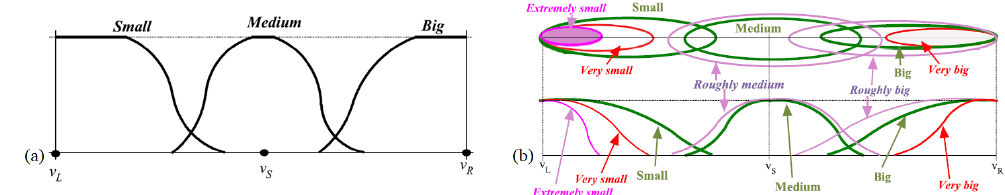
Figure 1. ( a ) Fuzzy sets modeling extensions of expressions that form the fundamental linguistic trichotomy; ( b ) Scheme of extensions of evaluative expressions with